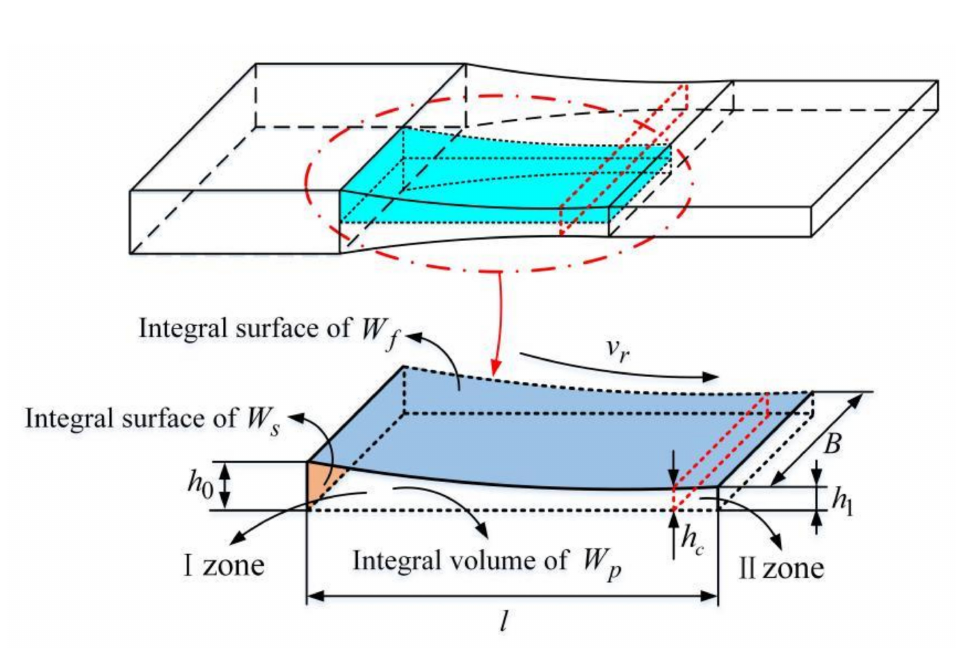
Figure 5. Integral limit of deformation